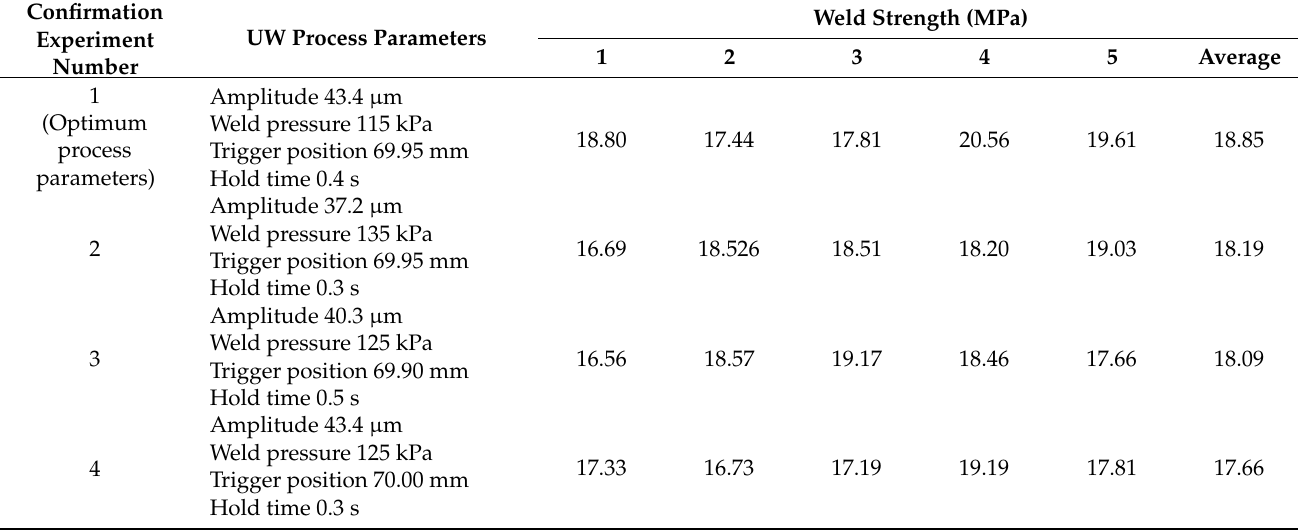
Table 5. Results of verifying optimum process